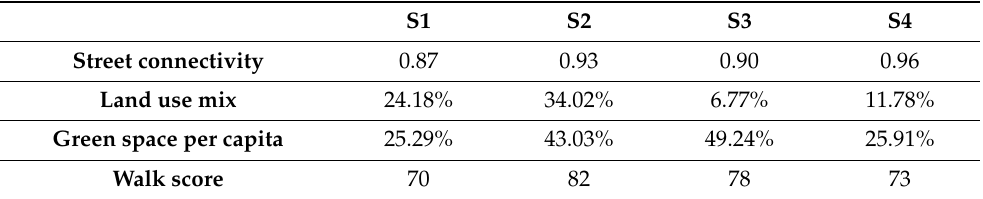
Table 4. Summary of the built environment of four colleges ( n =